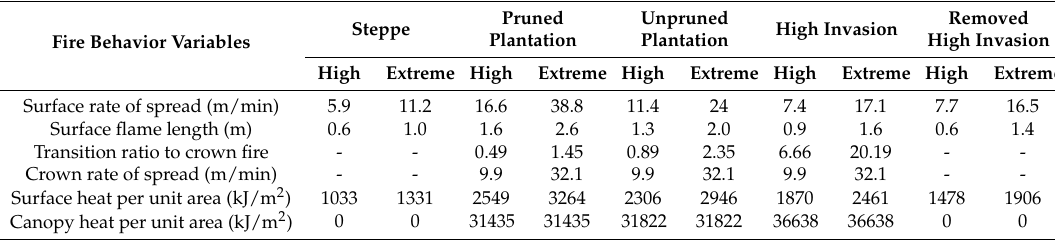
Table 3. Potential fire behavior in two contrasting fire danger scenarios (high and extreme danger) for the five selected treatments. High danger consists of a scenario with fine fuel moisture content of 5% and a 7-m wind speed of 20 km/h, while extreme danger implies fine fuel moisture of 1% and a 7-m wind speed of 40 km/h. Steppe Fire Behavior Variables High Extreme High Extreme High Extreme High Extreme High Extreme Surface rate of spread